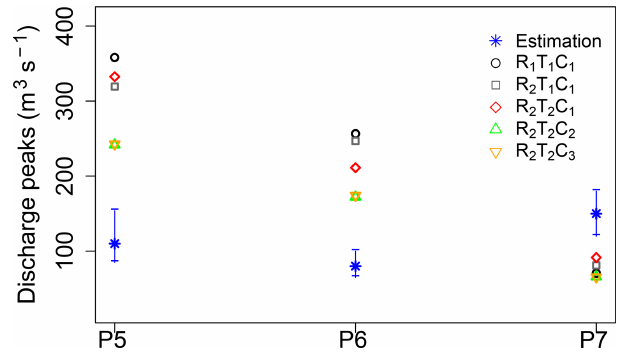
Figure 15. Estimated or simulated peak flows (m 3 s − 1 ) during the September 2015 event. The error margins (blue segments) of the peak values were estimated using post-event